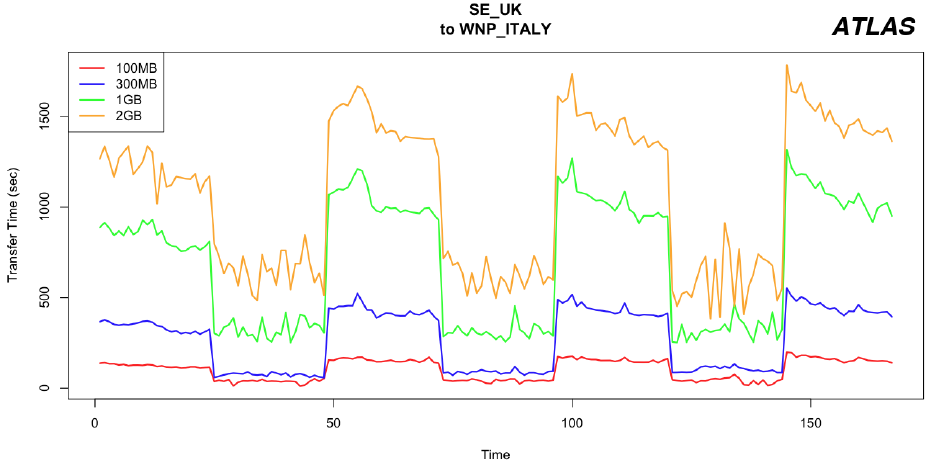
Figure 3. Throughput